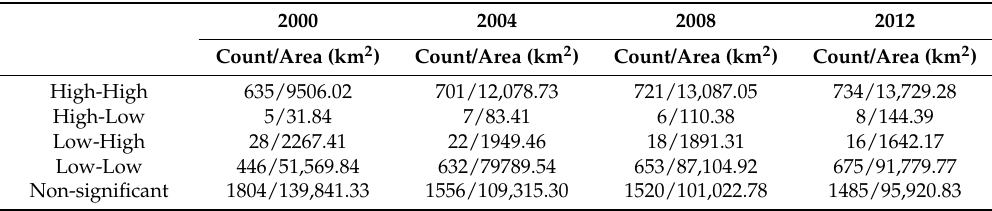
Table 2. Count and area of each type of spatial cluster towns in Beijing-Tianjin-Hebei urban agglomeration during